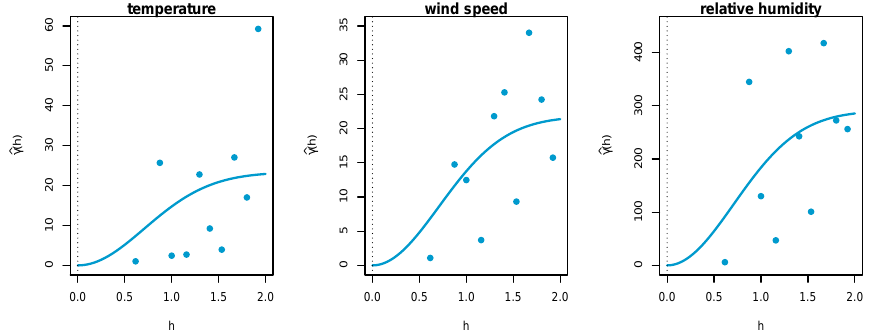
Figure 16. Curves: semivariance models ˆ γ ( h ) for temperature, wind speed, and relative humidity; points: empirical semivariance ˆ γ z ( h ) calculated by